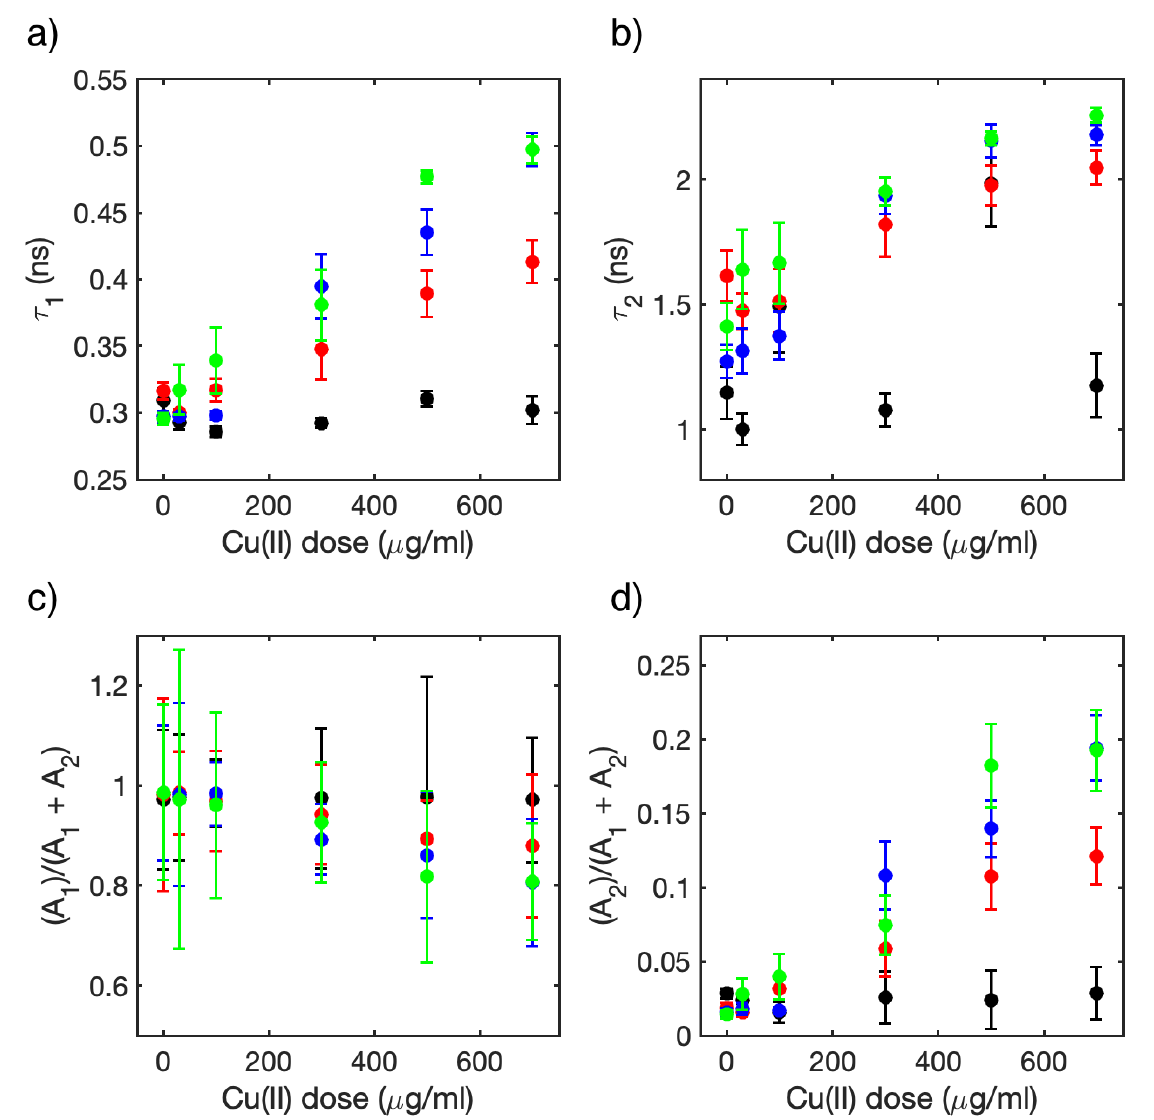
Figure 8. Average values of the parameters for the bi-exponential functions used to fit the 10 FLIM images of the C. cimbrica cells for each dose and time; in all plots black represents t = 0 h, red t = 24 h, blue t = 48 h, and green t = 72 h: ( a ) short time constant, ( b ) long time constant, ( c ) relative value of the area of the decaying signal associated to the short component (see text), and ( d ) relative value of the area of the decaying signal associated long component (see text).